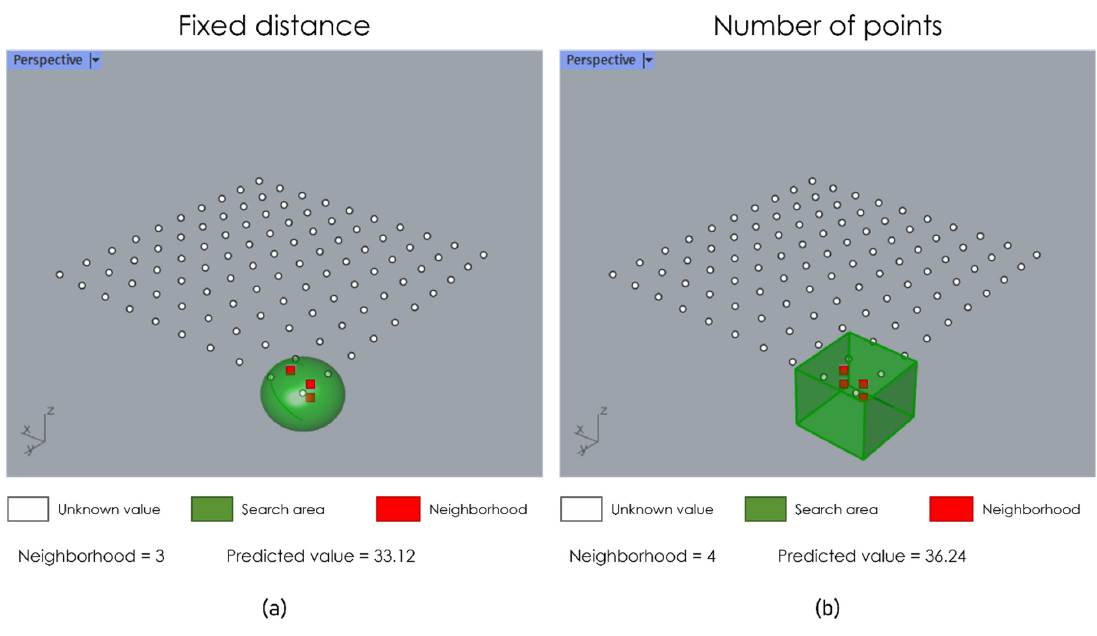
Figure 8. Limiting neighborhoods used for improved IDW: ( a ) Fixed search radius; ( b ) Fixed neigh- borhood counts.